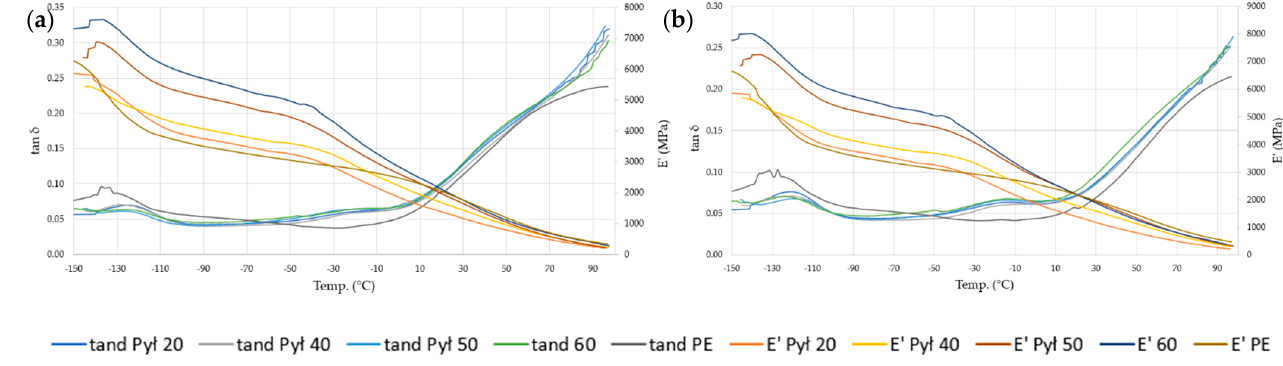
Figure 13. DMTA charts for dust scale samples: ( a ) vibration frequency 1 Hz, ( b ) 10 Hz.